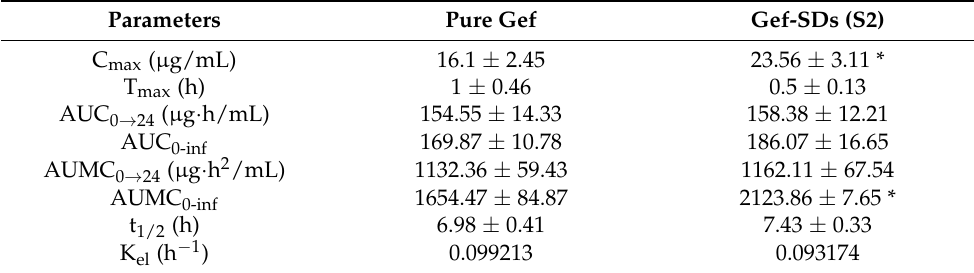
Figure 11. In vivo pharmacokinetic profile of pure Gef and Gef-SD (S2) after oral administration in rats (mean ± SD, n = 6.0). Table 2. Pharmacokinetic parameters after oral administration of Gef-SD (S2) and pure Gef suspen- sion (mean ± SD, n =